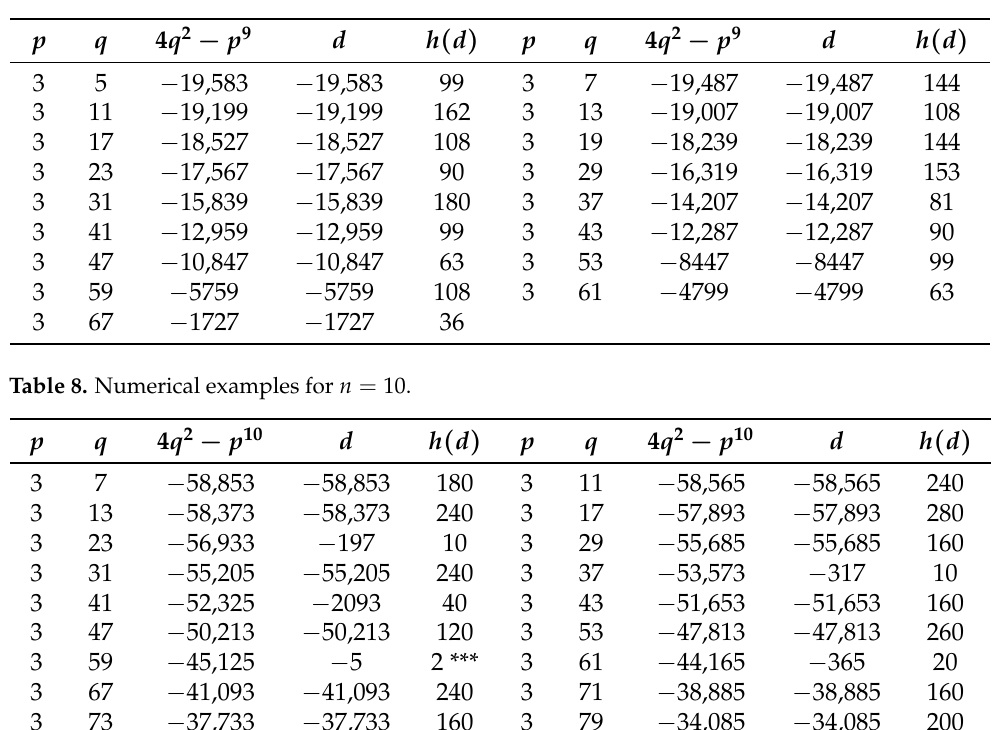
Table 7. Numerical examples for n = 9.